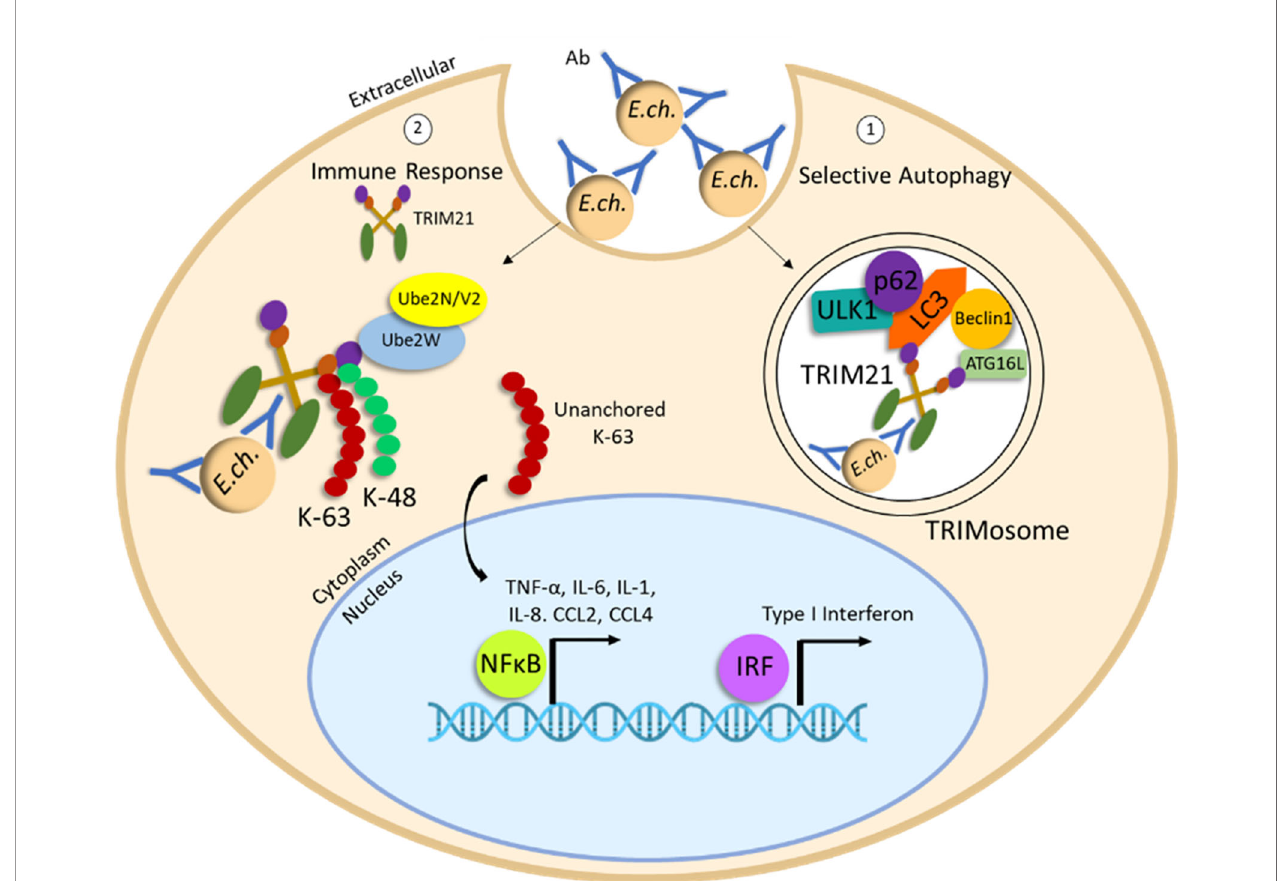
FIGURE 3 | Degradation of E. chaffeensis by antibody-TRIM21-mediated selective autophagy. Ehrlichiae opsonized with E. chaffeensis -OMP-1 speci fi c antibody are internalized by unknown uptake mechanism. Intracellular antibody-opsonized ehrlichiae are recognized by cytosolic Fc receptor TRIM21. (1) Induction of TRIMosome formation and selective autophagy occurs through recruitment of autophagy regulators, ULK1, Beclin 1, ATG16L and autophagy effectors LC3/GABARAP and p62/ SQSTM1. (2) E. chaffeensis -Ab/TRIM21 complex stimulates rapid immune signaling and a proin fl ammatory response through accumulation of K48 and K63 polyUb chains and activation and nuclear translocation of NF- k B and